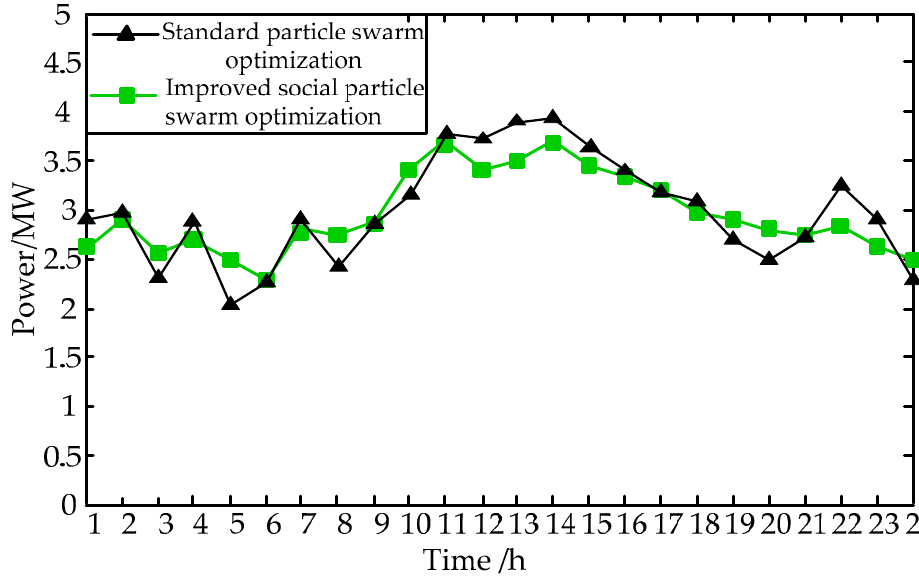
Energies 2020 , 13 , x FOR PEER REVIEW Figure 12. The comparison of the joint output curves between the two strategies on typical day A.